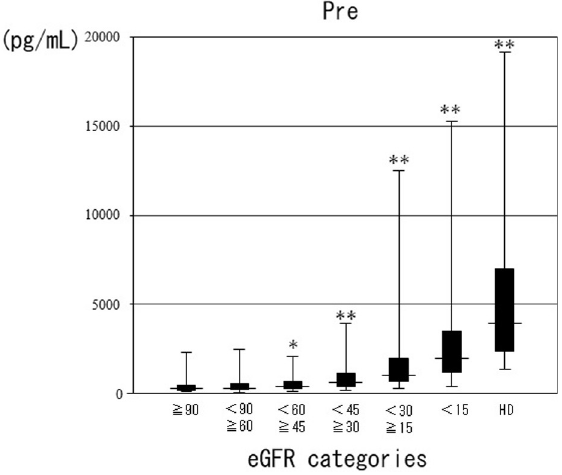
Fig 2. Pre values in different eGFR categories. eGFR: estimated glomerular filtration rate; Pre: presepsin value; ns: not significant. The horizontal bars represent the median, the boxes represent the IQR, and the vertical bars represent the upper and lower limits. p values calculated by Dunnett-Hsu’s analysis adjusted by sex and age. � p < 0.05 �� p < 0.01 compared with �